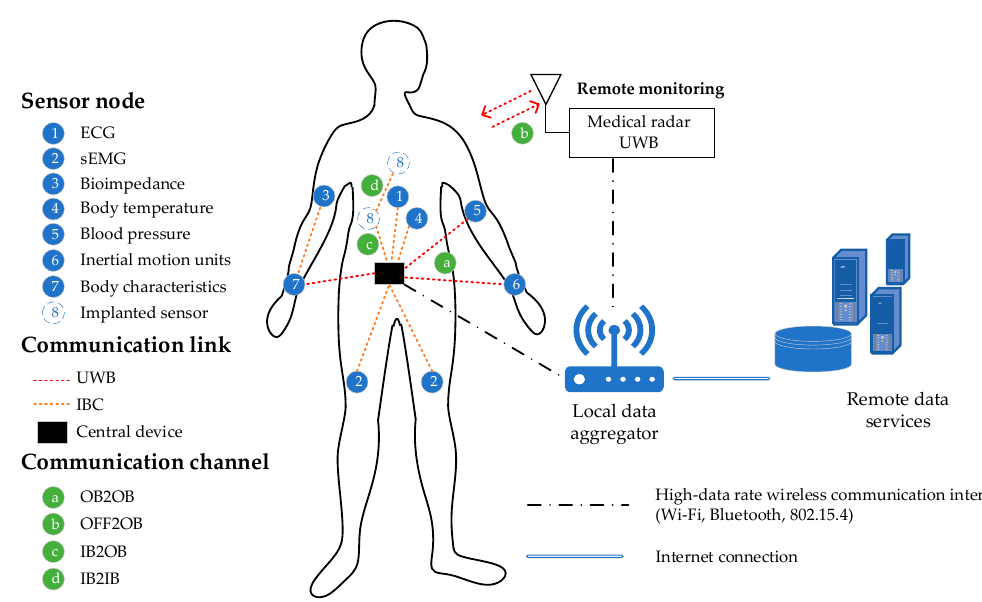
Figure 1. Wireless sensor network (WSN) topology of ultra-wideband (UWB) and intrabody communication (IBC) wireless body area network (WBAN).